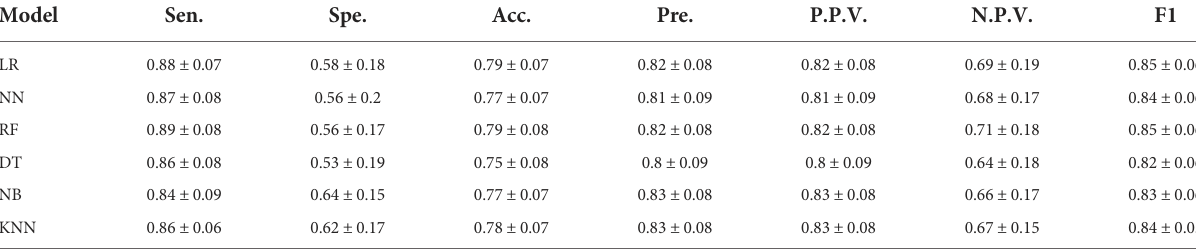
TABLE 3 Predictive performance of each model.